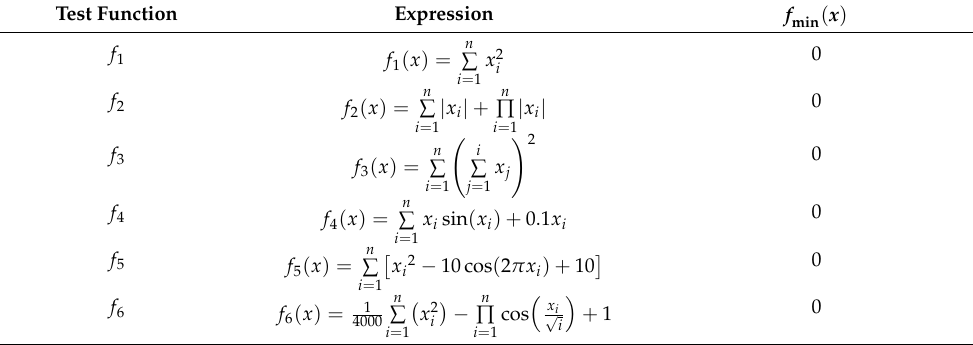
Table 2. Test function.